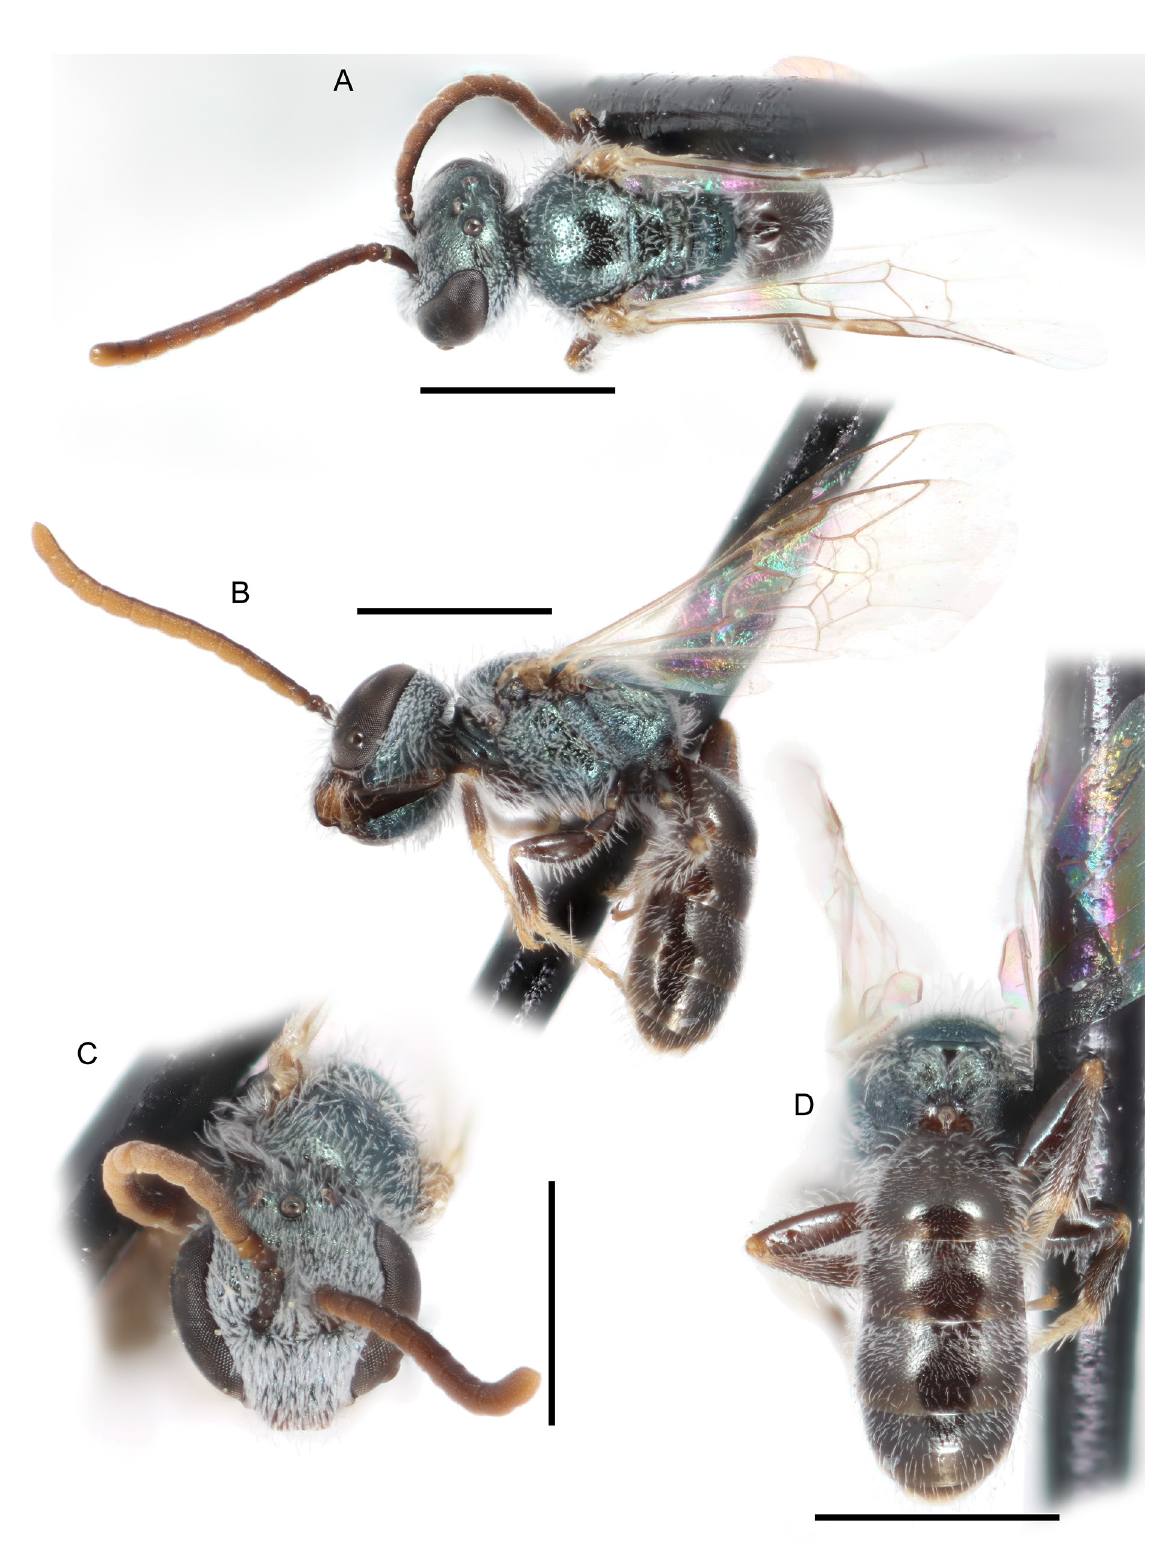
Fig. 23. Lasioglossum ( D. ) clastipedion sp. nov., ♂. A . Dorsal habitus. B . Lateral habitus. C . Face. D . Propodeum and metasoma. Scale bars: 1